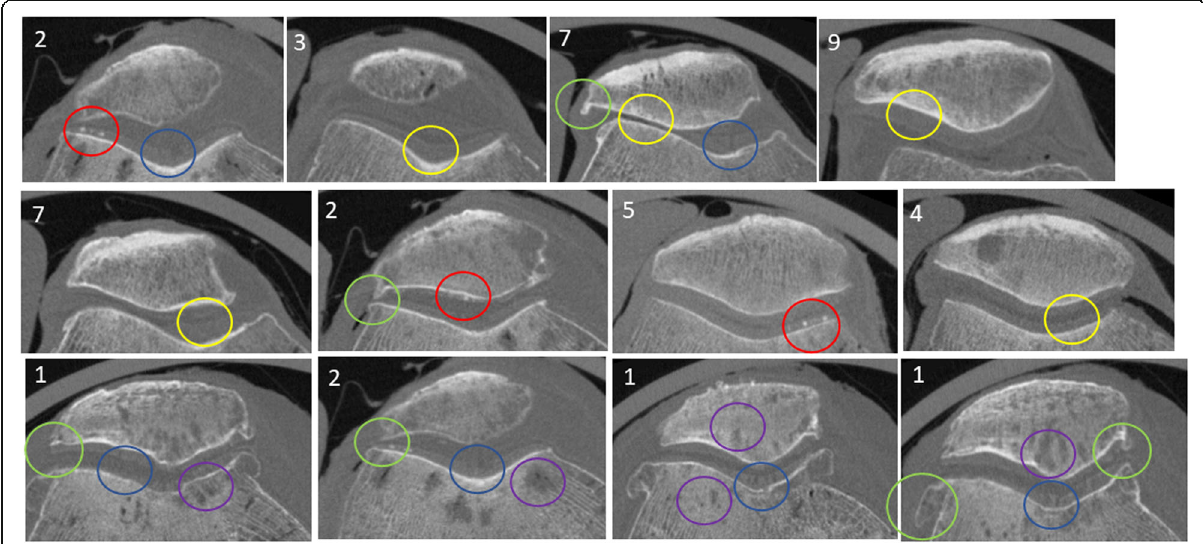
Fig. 4 Transversal views of the selected 60 keV monoenergetic images for six specimens, the specimens 1 and 2 are severe osteoarthritis and sample 7 moderate osteoarthritis with numbers corresponding to samples. Red circle, cartilage calcifications; yellow circle, cartilage with different thicknesses; blue circle, cartilage defects; purple circle, bone cysts of various size; green circle: osteophytes of various size